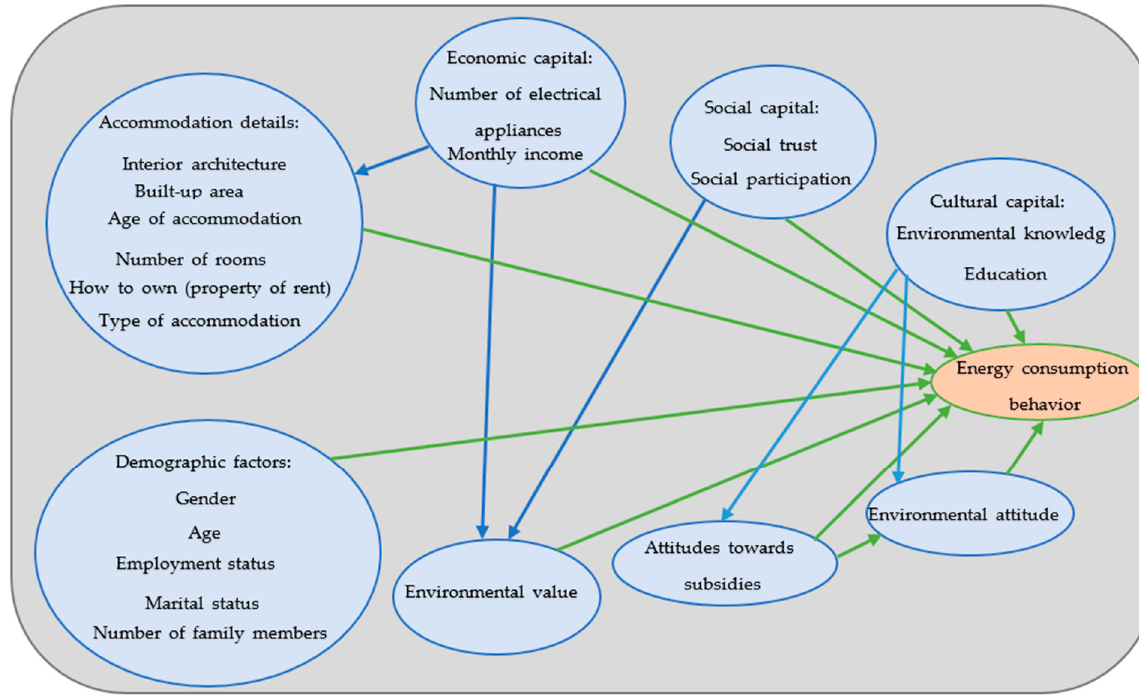
Figure 2. Analytical model.